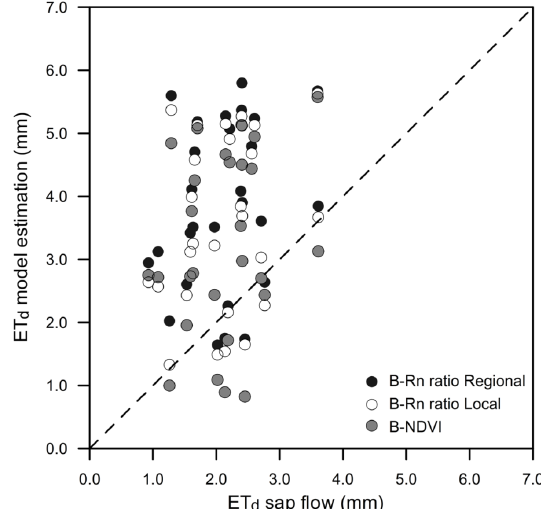
Figure 6. Relationship between daily evapotransporation (ET d ) calculated from sap flow measurements and modelled using AQUA MODIS data and the B parameter estimation in mm·day -1 . B-R n ratio regional is the B approach using the regional R n ratio, B-R n ratio local is the B approach using the local R n ratio and B-NDVI is the B approach using the NDVI.